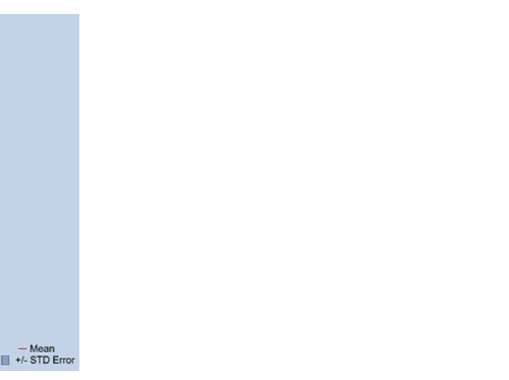
Fig 2. MiR-155 plasma expression level a) p = 0,0002, b) p = 0,009, c) p = 0,00004.